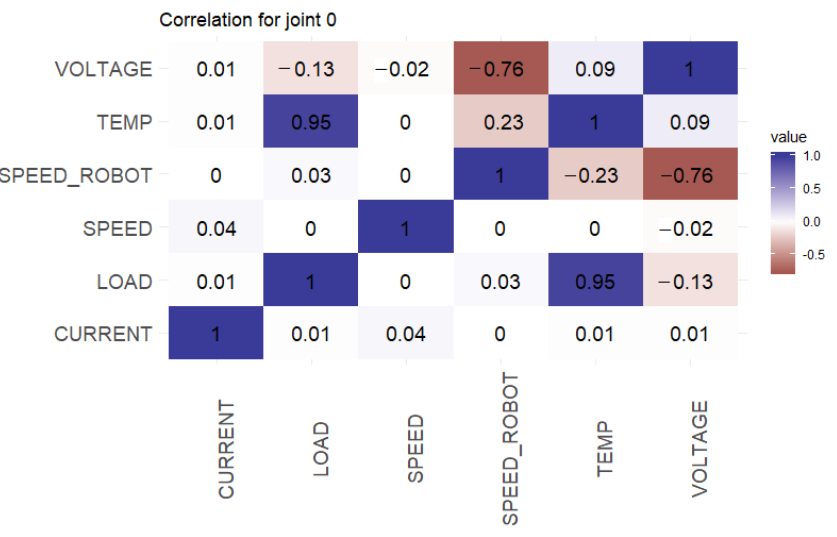
Figure 4. Correlation matrix of joint